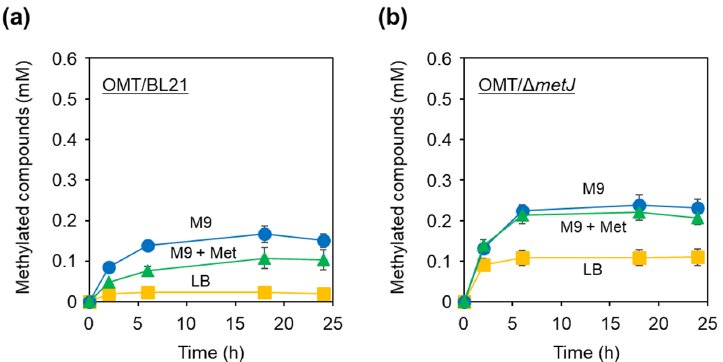
Figure 2. Effect of the medium used for cell preparation on methylation reaction. Time course data of esculetin methylation using OMT/BL21 cells ( a ) and OMT/ Δ metJ cells ( b ). Each strain was cultivated in LB medium (orange), M9 medium (blue), or M9 medium supplemented with 1 mM methionine (green) prior to the methylation reaction. The concentration of the methylated products is shown as the sum of the concentrations of scopoletin and isoscopoletin. Data points represent the mean ± standard deviations for three independent experiments.